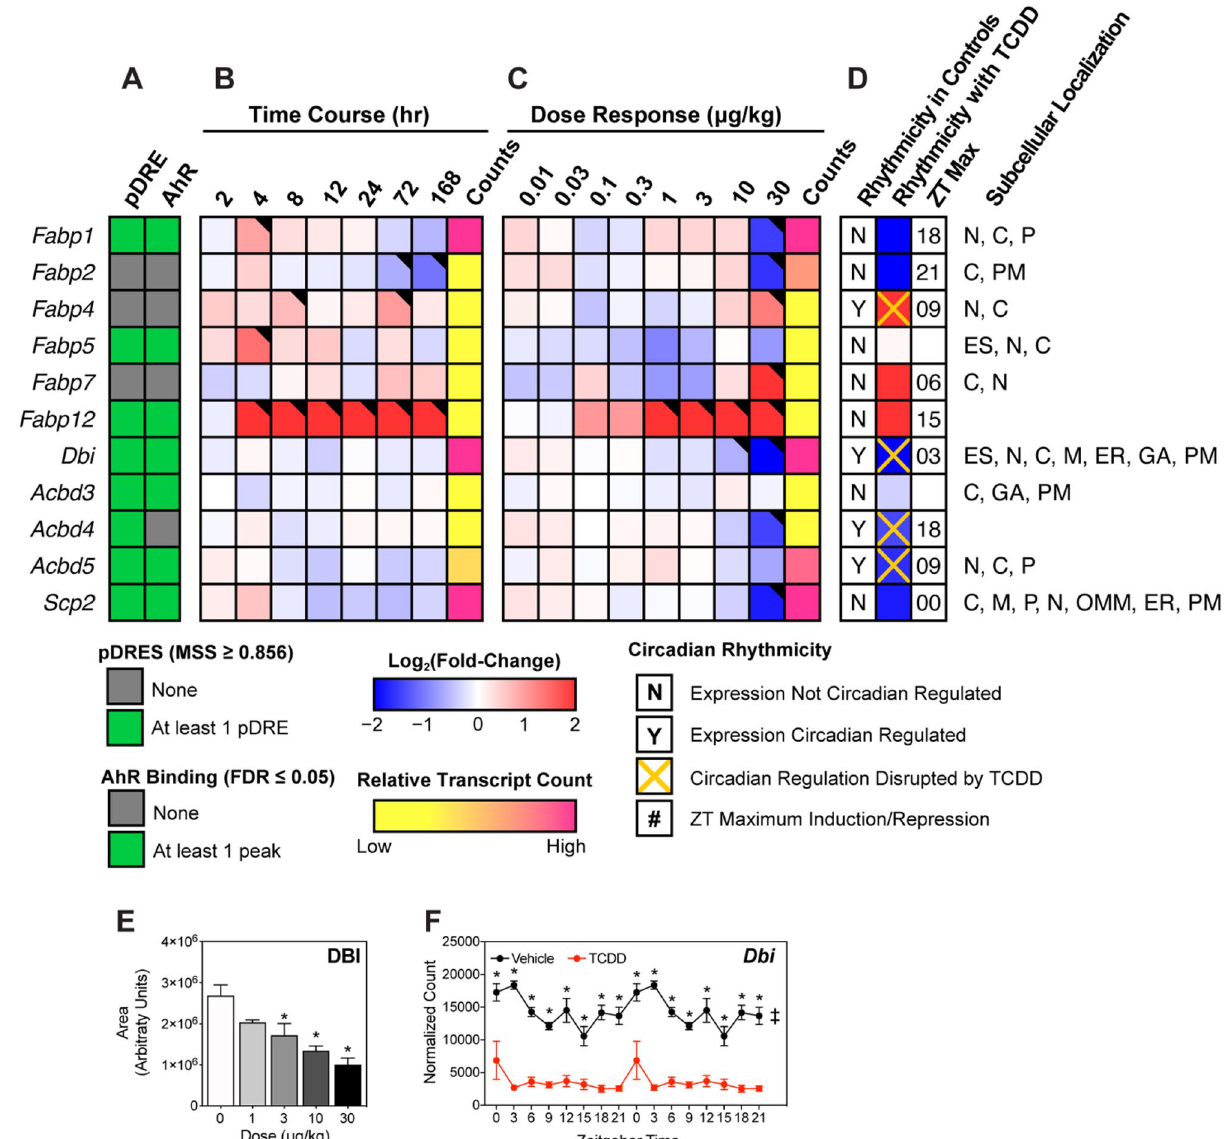
Figure 2. Effect of TCDD on intracellular fatty acid trafficking proteins. Differential expression of genes associated with intracellular fatty acid trafficking assessed using RNA-seq. Mouse Genome Informatics (MGI) official gene symbols are used. ( A ) The presence of putative dioxin response elements (pDREs) and AHR genomic binding at 2 h. ( B ) Time-dependent gene expression following a single bolus dose of 30 μg/kg TCDD (n = 3). ( C ) Dose-dependent gene expression assessed following oral gavage every 4 days for 28 days with TCDD (n = 3). ( D ) Diurnal regulated gene expression denoted with a “Y”. An orange ‘X’ indicates abolished diurnal rhythm following oral gavage with 30 μg/kg TCDD every 4 days for 28 days. ZT indicates statistically significant (P1( t ) > 0.8) time of maximum gene induction/repression. Counts represent the maximum number of raw aligned reads for any treatment group. Low counts (< 500 reads) are denoted in yellow with high counts (> 10,000) in pink. Differential gene expression with a posterior probability (P1( t )) > 0.80 is indicated by a black triangle in the top right tile corner. Protein subcellular locations were obtained from COMPARTMENTS and abbreviated as: cytosol (C), endoplasmic reticulum (ER), extracellular space (ES), Golgi apparatus (GA), mitochondrion (M), outer mitochondrial membrane (OMM), nucleus (N), peroxisome (P), and plasma membrane (PM). ( E ) Capillary electrophoresis was used to assess DBI protein levels in total lysate prepared from liver samples harvested between ZT0-3 (n = 3). Bar graphs denote the mean ± SEM. Statistical significance (*p ≤ 0.05) was determined using a one-way ANOVA followed by Dunnett’s post-hoc analysis. ( F ) Diurnal expression of Dbi was assessed by RNA-seq (n = 3). Asterisks denotes a posterior probability (P1( t ) > 0.8) within the same timepoint comparing vehicle to TCDD. Diurnal rhythmicity (‡) was determined using JTK_CYCLE for each treatment. Circadian data are plotted twice along the x-axis to better visualize the gene expression rhythmicity. The heatmap was created using R (v4.0.4). Plots were created using GraphPad Prism